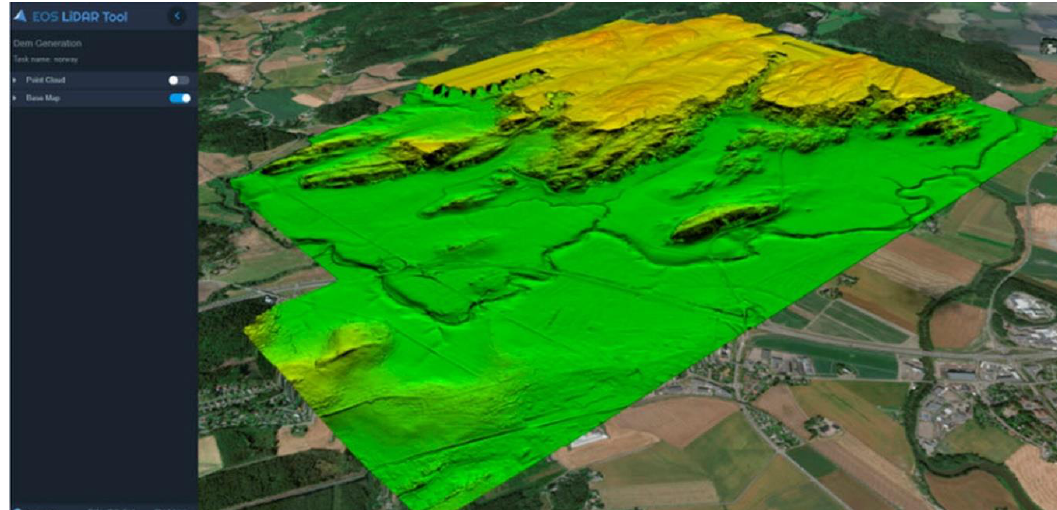
Figure 6. Visualization of post-glacial landforms in Norway. The visual is presented from the ELiT Server web-interface.